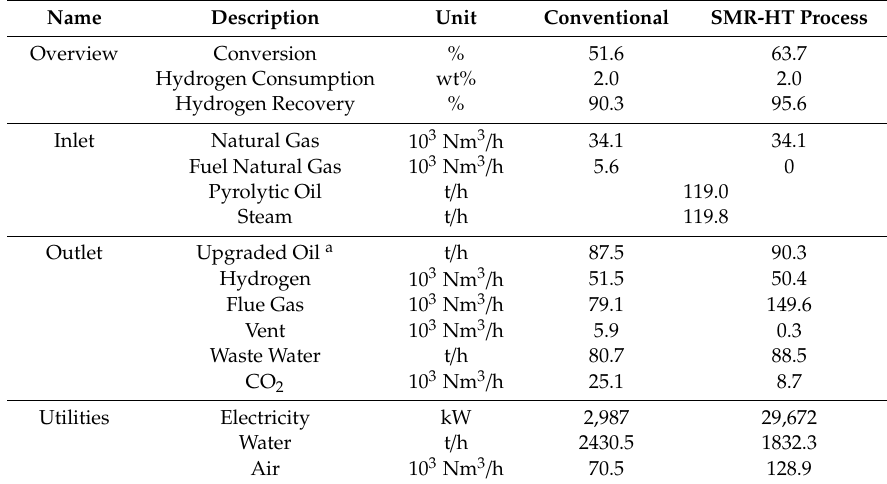
Table 5. Process evaluations.